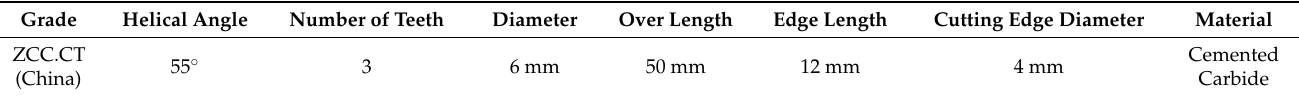
Table 2. Characteristics of the